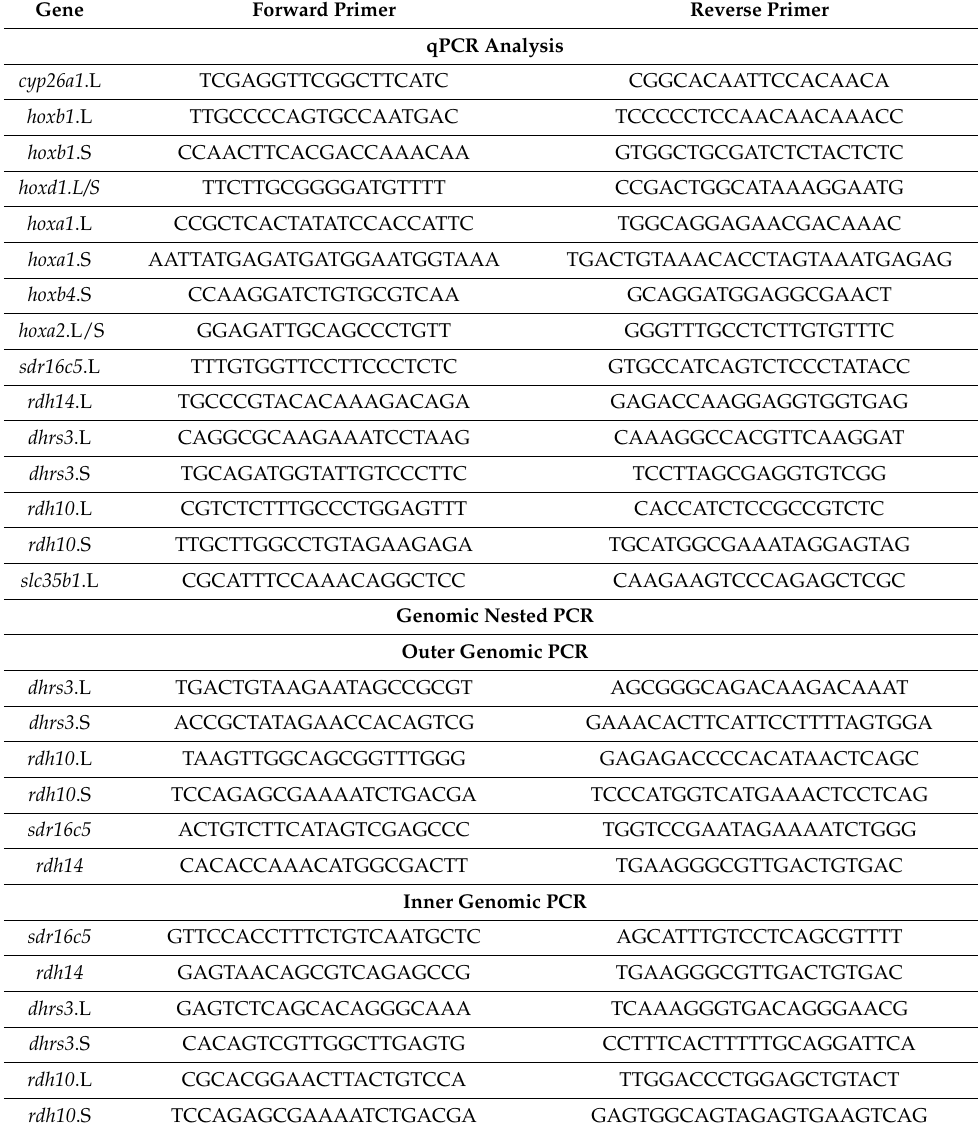
Table 1. Sequences for qPCR and genomic DNA amplification primers and